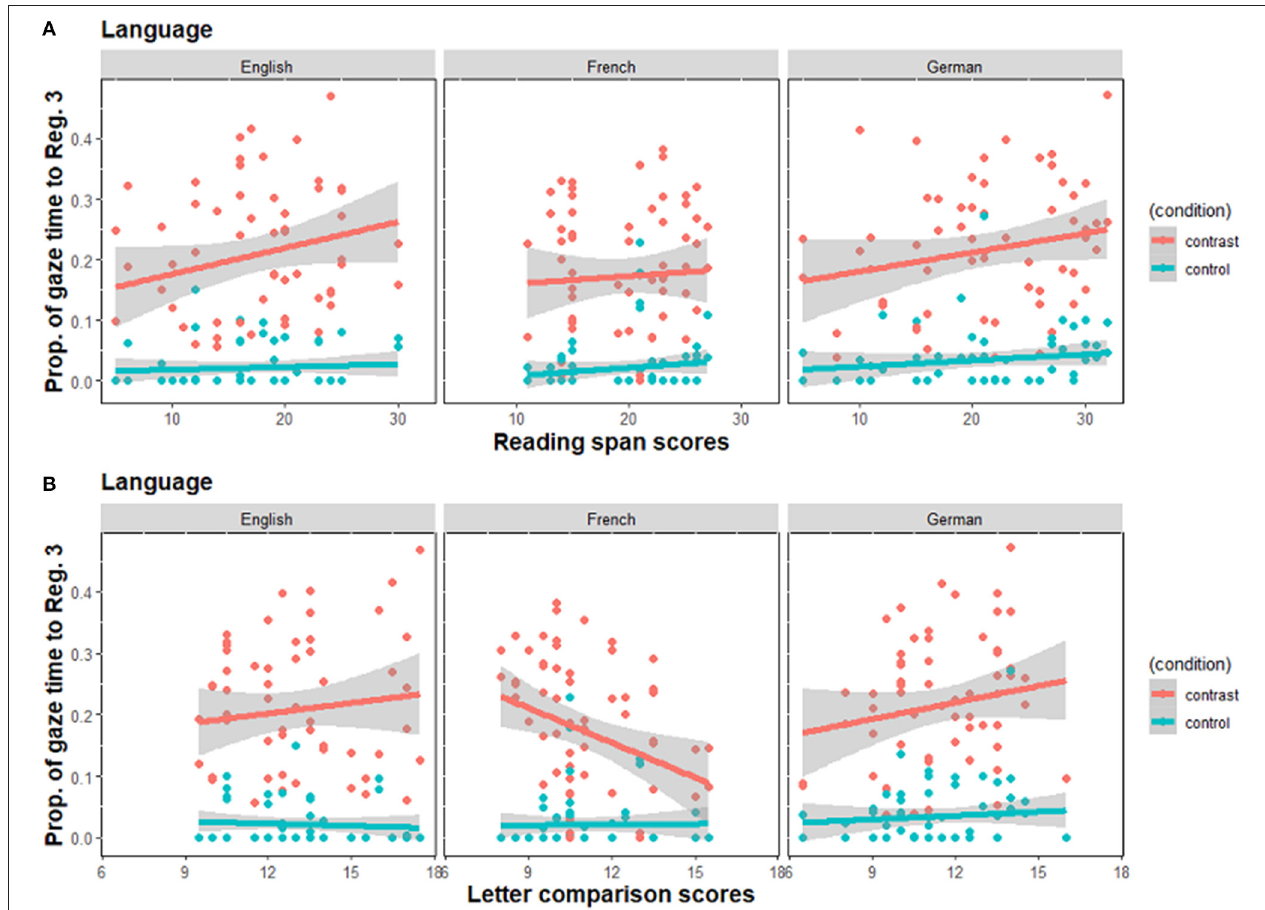
FIGURE 5 | Proportion of gaze time to Region 3 per utterance as a function of (A) working memory scores as measured by the reading span task, and (B) speed of processing scores as measured by the letter comparison task. The gray bands represent 95% confidence interval for the regression lines. Contrast, Contrast condition; control, Control